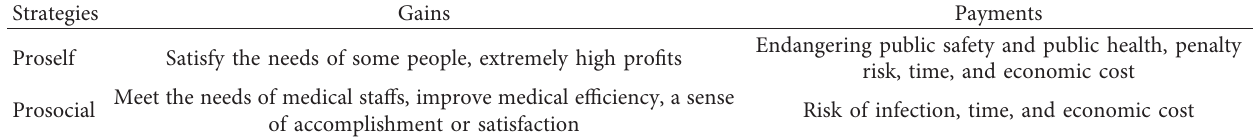
Table 1: Matrix of utility under different strategies.